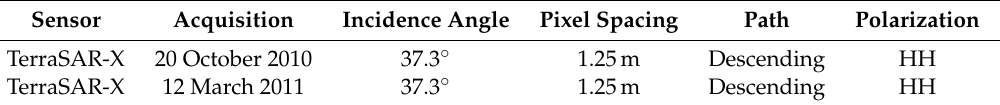
Table 1. Details of the acquisition of SAR images used in this study.